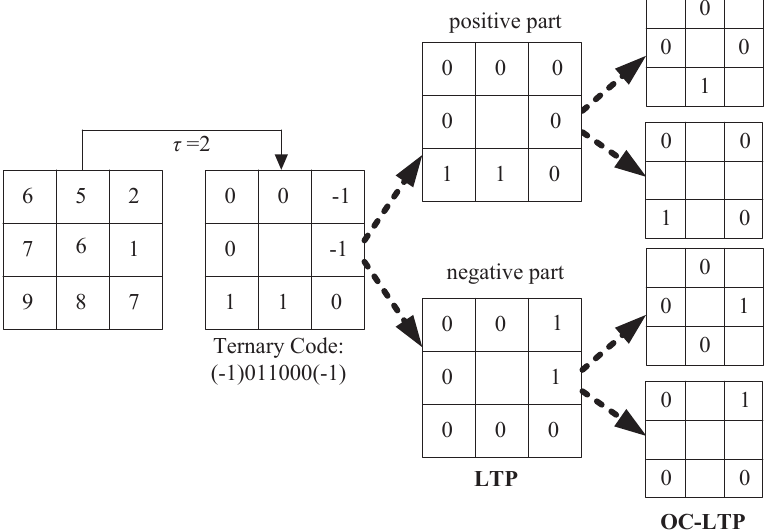
Figure 3. Calculation of the OC_LTP operators with eight neighboring pixels. Table 1. Dimensionality